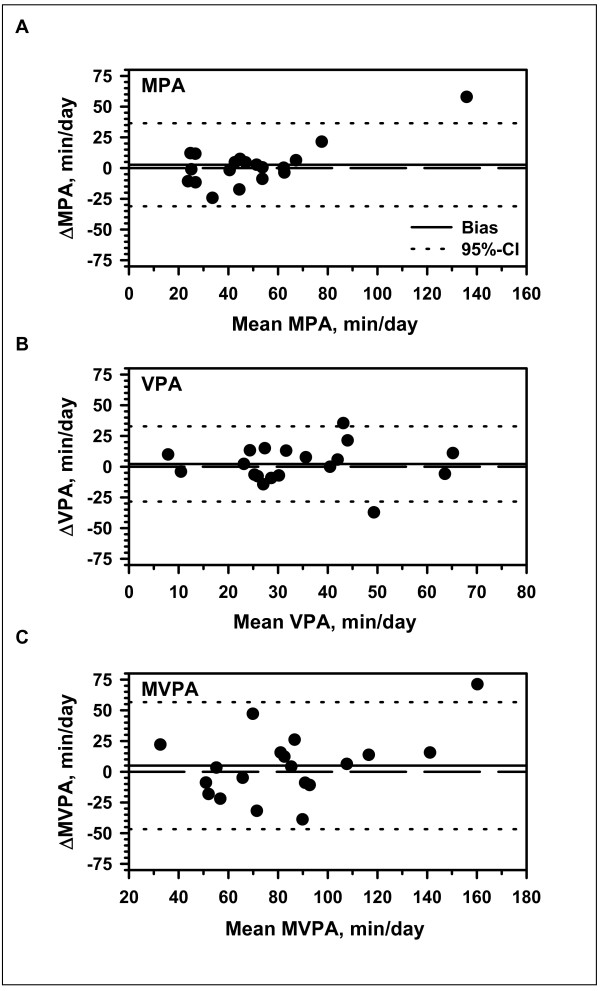
Bland-Altman plots of the test-retest accelerometry data for each activity category; A: Moderate physical activity (MPA), B: Vigorous physical activity (VPA) C: Moderate and vigorous physical activity (MVPA).